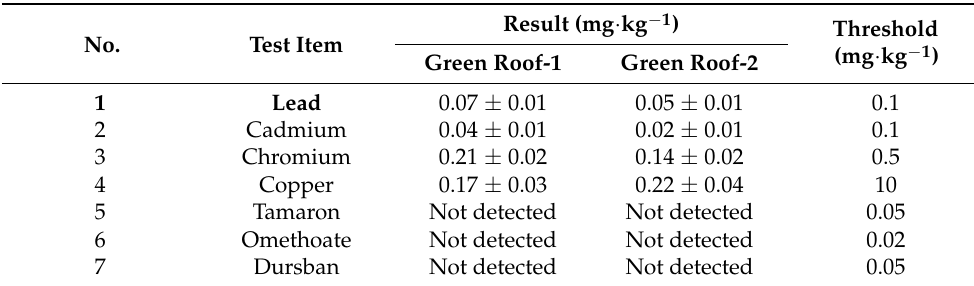
Table 2. Results of tests for metals in water spinach produced by the GR system (mean ± standard deviation, n = 6).